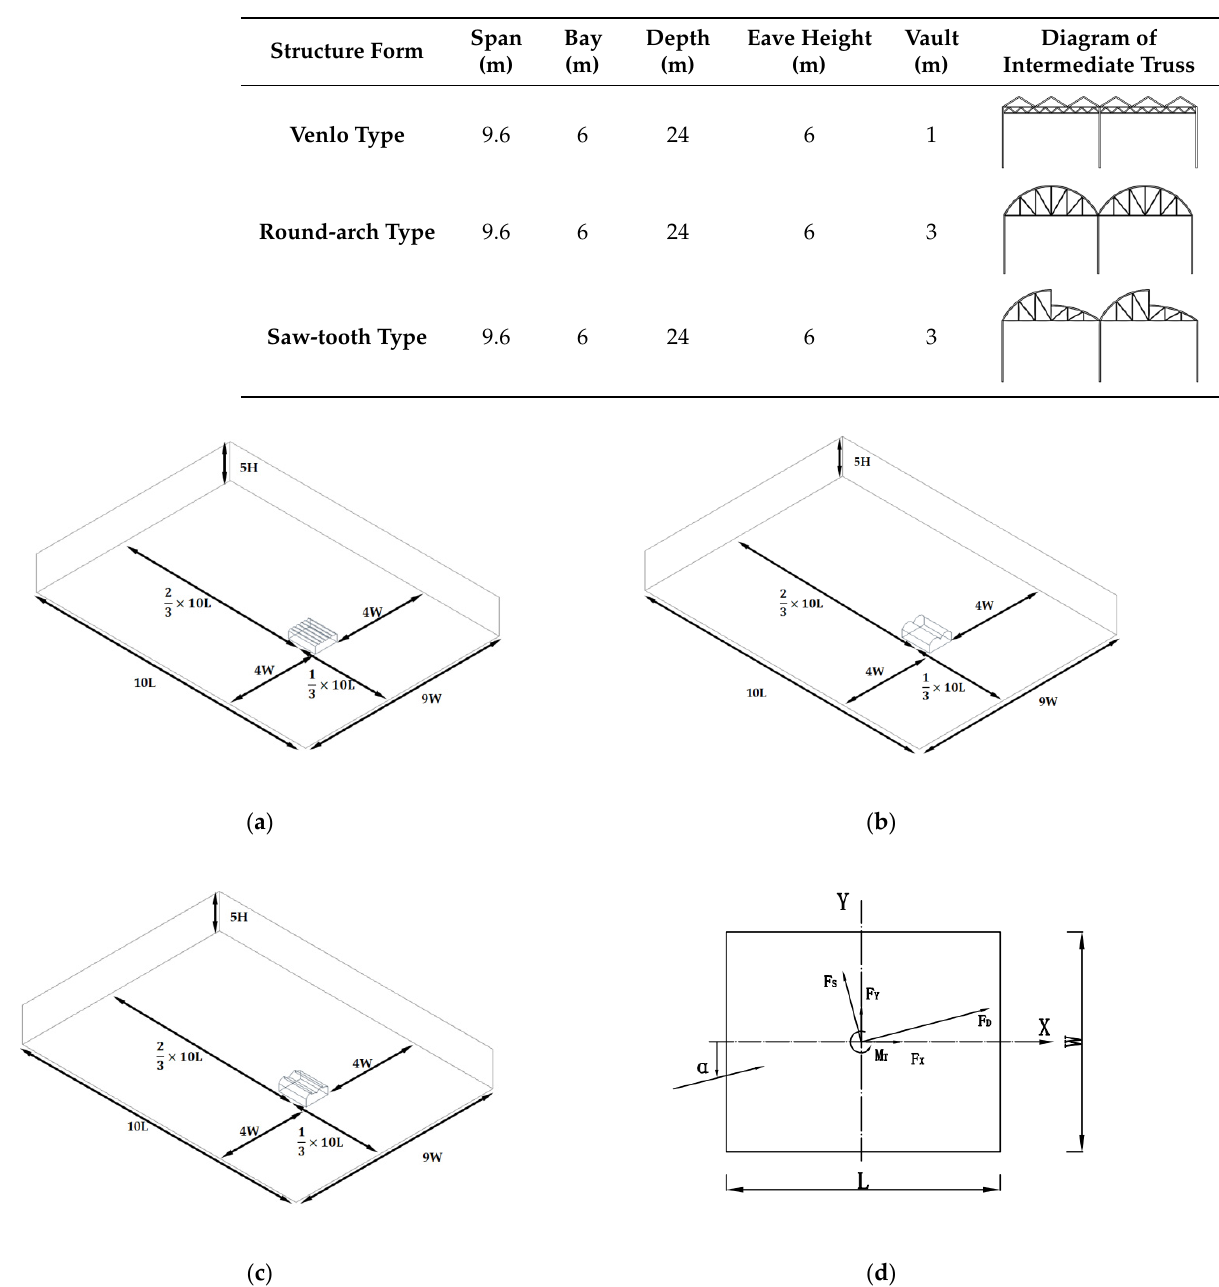
Figure 1. Perspective view of the three kinds of greenhouses in its computational domain. ( a ) Venlo Type; ( b ) Round-arch Type; ( c ) Saw-tooth Type; ( d ) Definition of each wind. Note: L, W, H represent the length, width, and height of the green house, respectively, and they are 24 m, 19.2 m, 6 m, respectively. α is the wind angle; F X is the horizontal force in the X-direction; F Y is horizontal force in the Y-direction; F D is the downwind horizontal force; F S is the horizontal force perpendicular to the wind direction; M T represents the torque around the Z